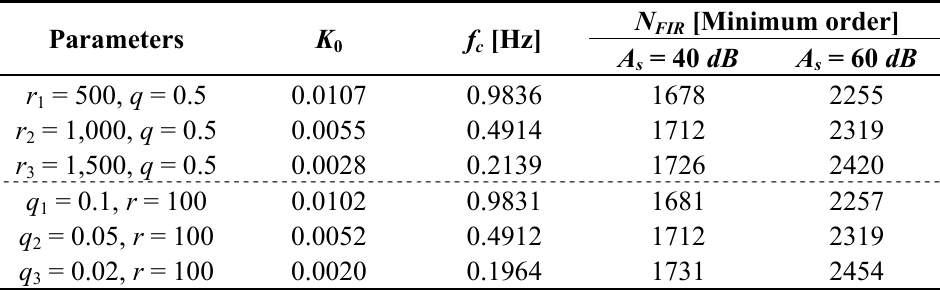
, f and N with different q and r . 0 c FIR